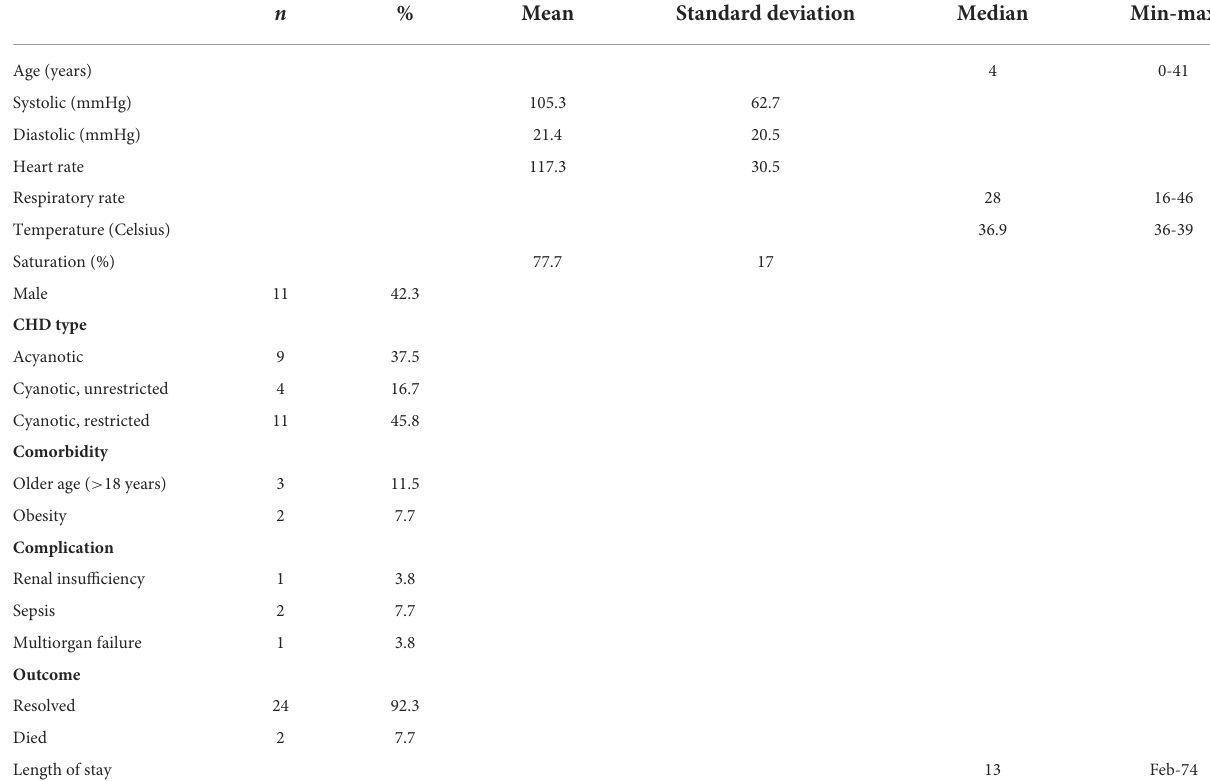
TABLE 1 Baseline